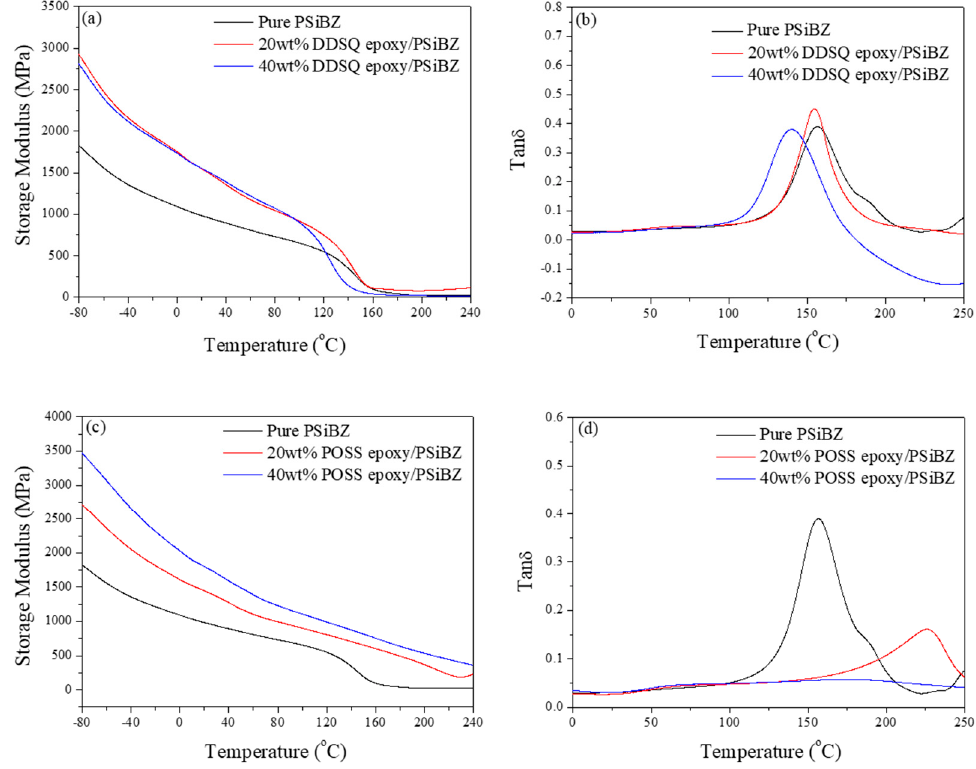
Figure 3. TGA thermograms of ( a ) DDSQ / PSiBZ nanocomposites and ( b ) POSS epoxy / PSiBZ nanocomposites.